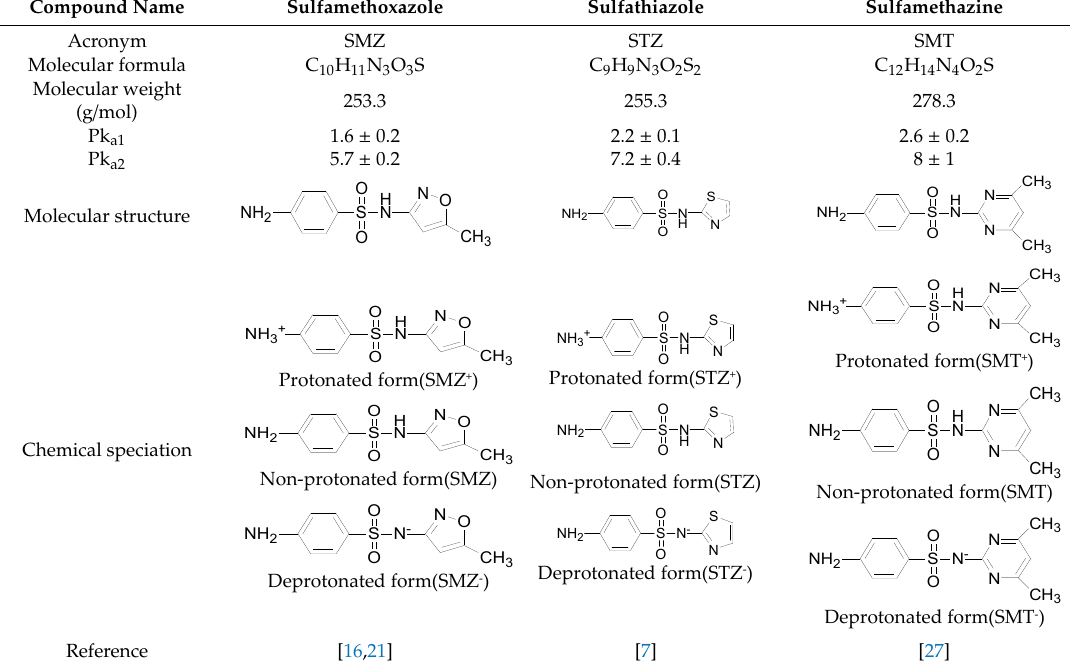
Table 1. Chemical structures and relevant data for selected sulfonamides.